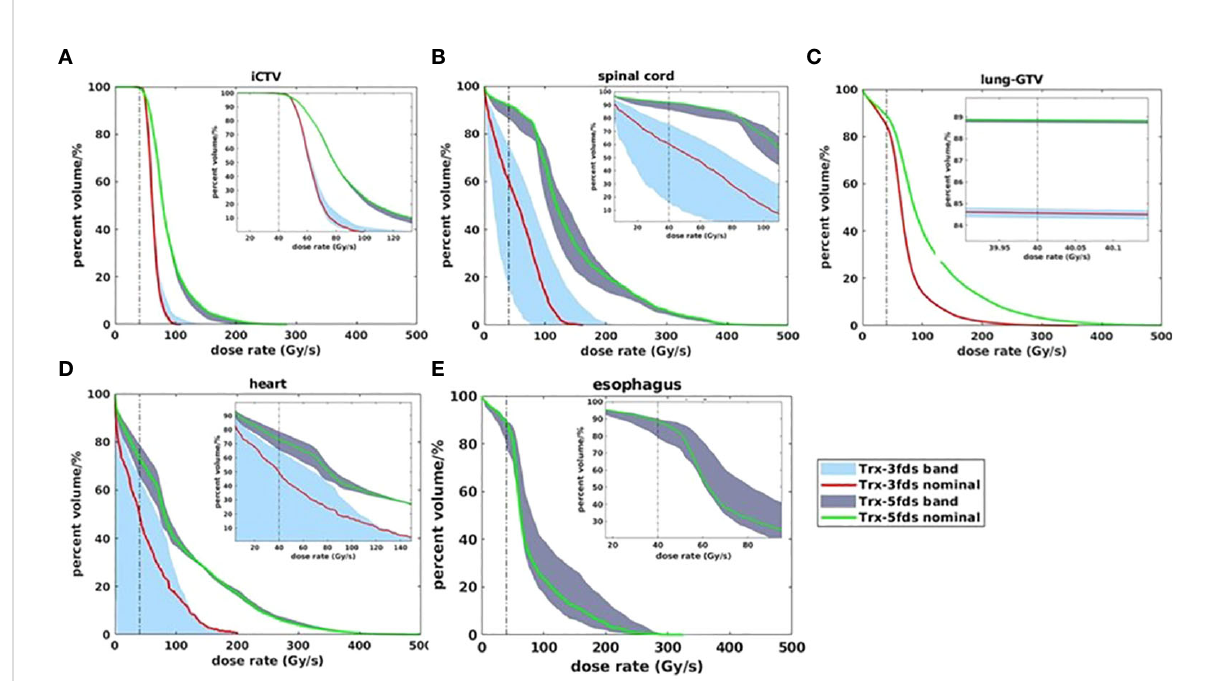
FIGURE 8 DRVH bands for different RT structures for Trx-3fds and Trx 5fds for patient #2, target iCTV (A) and OARs spinal cord, lung-GTV, heart, and esophagus (B – E) .